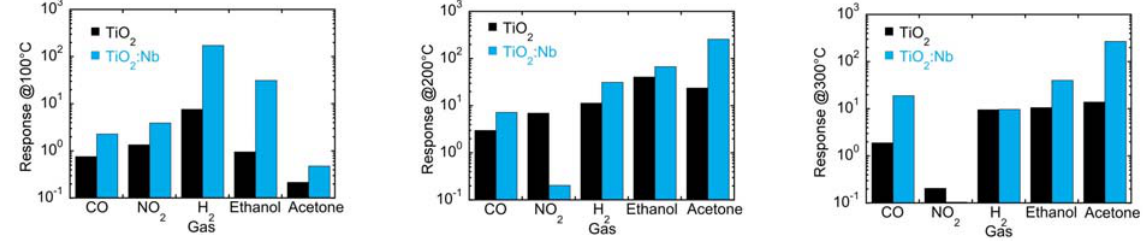
Figure 16. Response towards carbon monoxide, nitrogen dioxide, hydrogen, ethanol and acetone at 500 ppm, 10 ppm, 1,000 ppm, 500 ppm and 100 ppm, respectively and working temperatures of 100, 200 and 300 °C. Reprinted from [47] with permission. Copyright (2013) IOP Publishing